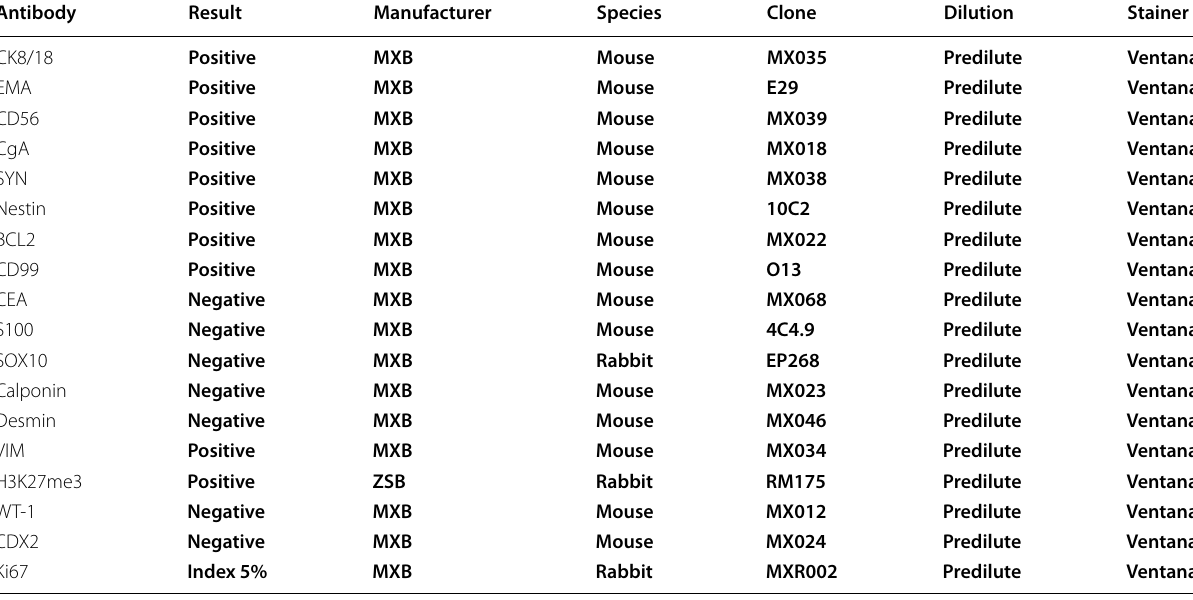
Table 1 Immunohistochemical stains with interpretation of the results and technical data Antibody